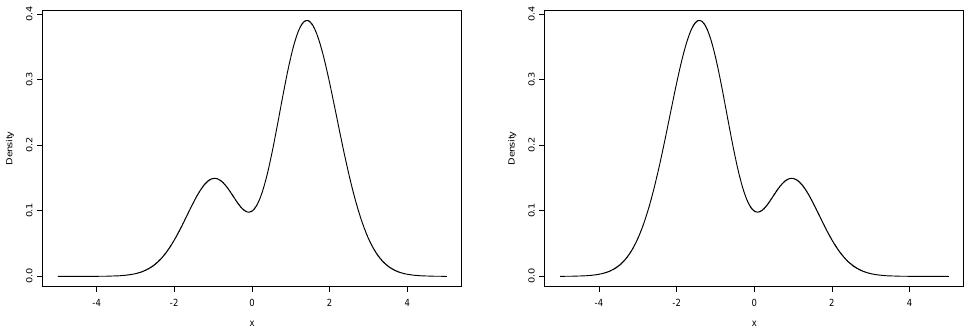
Figure 2. Density function for BSN ( λ , α ) with λ = 0.5 and α = 3 (left); λ = − 0.5 and α = 3